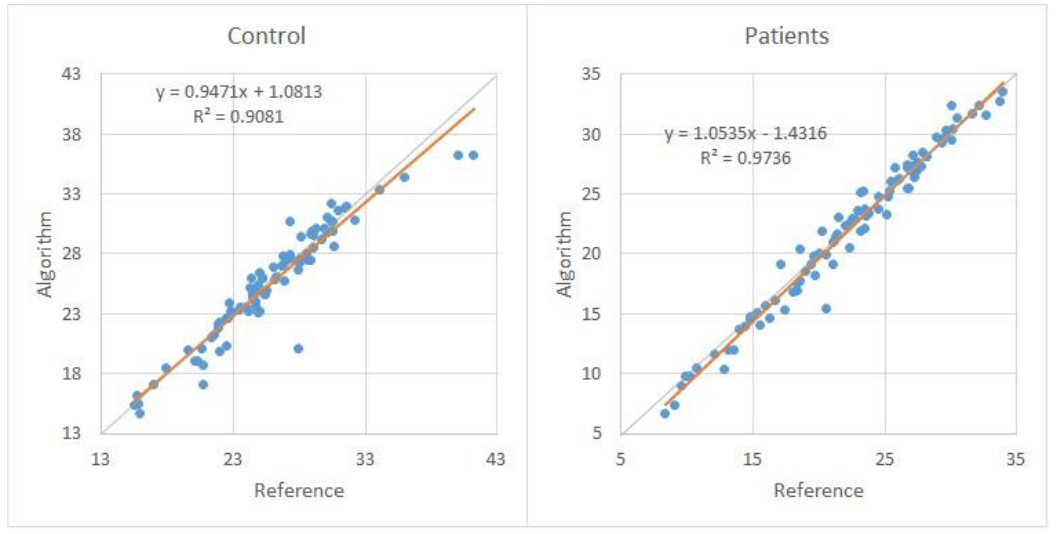
Figure 4. Comparison of HNR values for the 90 control measurements (left-hand side) and 90 patient measurements (right-hand side).